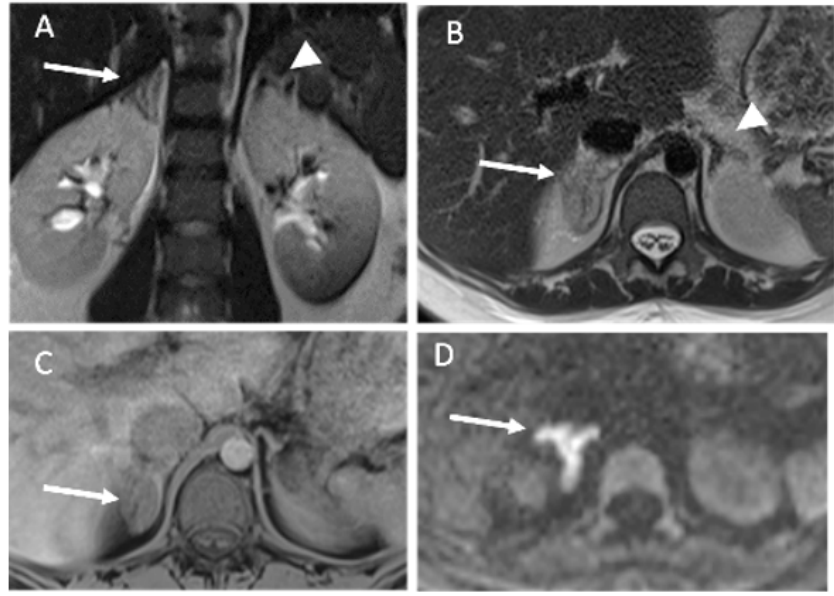
Figure 4. MRI findings of patient 3. ( A , B ) T2-weighted MR imaging, coronal ( A ) and axial ( B ) planes showing edema of the right adrenal gland (arrow) and adjacent fat. No abnormality of the contralateral gland (arrowhead). ( C ) Unenhanced axial T1-weighted imaging showing no hyperintensity of the adrenal gland (arrow). ( D ) Diffusion-weighted MR imaging (b800) showing restricted diffusion of the adrenal gland (arrow).